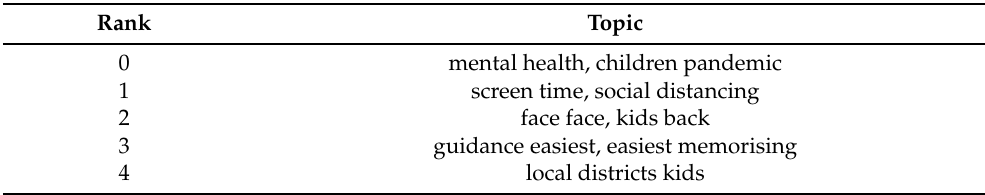
Table 3. Top five topics derived from the